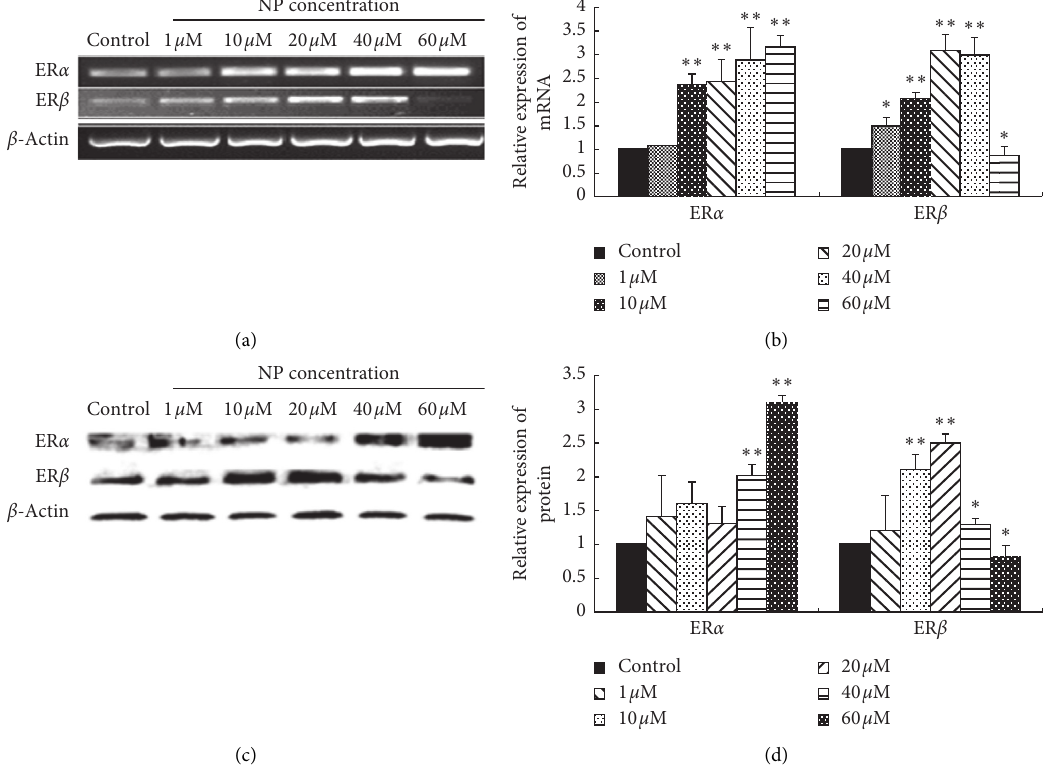
Figure 7: Protein and mRNA expression of ER- α and ER- β . (a) RT-PCR was performed for target genes and β -actin. (b) The histogram represents the quantification of ER- α and ER- β mRNA levels (levels of control cells/ β -actin defined as 1). (c) Western blot was performed for the target protein and β -actin. (d) The histogram represents the quantification of ER- α and ER- β protein levels (levels of control cells/ β -actin defined as 1). Results are presented as mean ± SD with triplicate measurement. ∗ P < 0 . 05, ∗∗ P < 0 . 01 versus the control